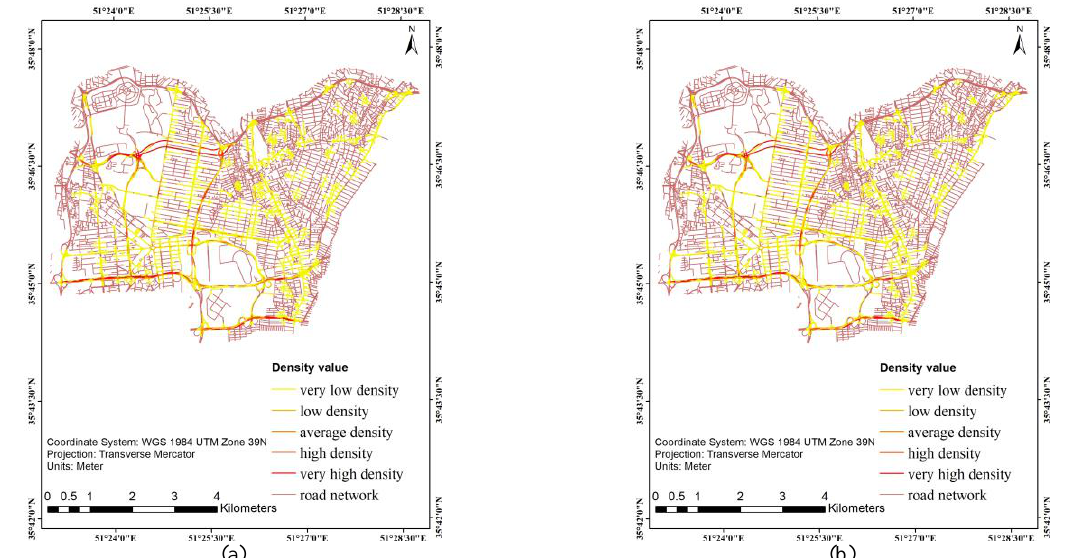
Figure 7. The output of the NKDE method (a) continuous kernel function (b) discontinuous kernel function According to Table 1, for damage car accidents the NKDE segments than those of the NKDE method with discontinuous method with continuous kernel function identifies more density kernel function in the road